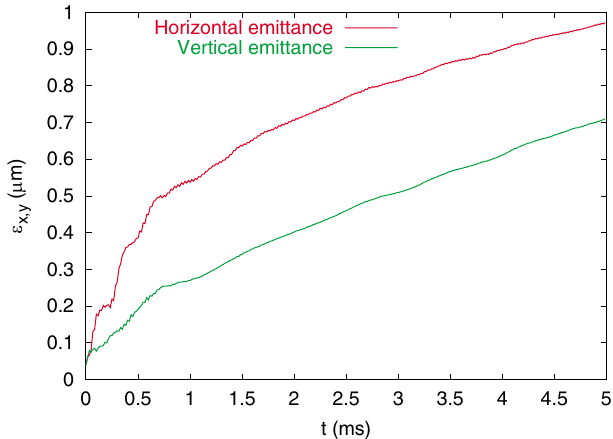
FIG. 44. (Color) HEADTAIL simulation result by Rumolo of horizontal and vertical emittance growth for the code bench- marking with the parameters of Table I; the horizontal scale extends over 5 ms, the vertical from 0 to 1 (cid:7) m ; one beam- electron interaction per turn was